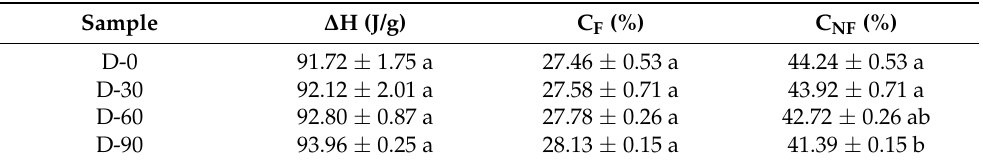
Table 1. Effect of proofing on the melt enthalpy, freezable water and non-freezable water contents in CS–HPMC gluten-free dough.